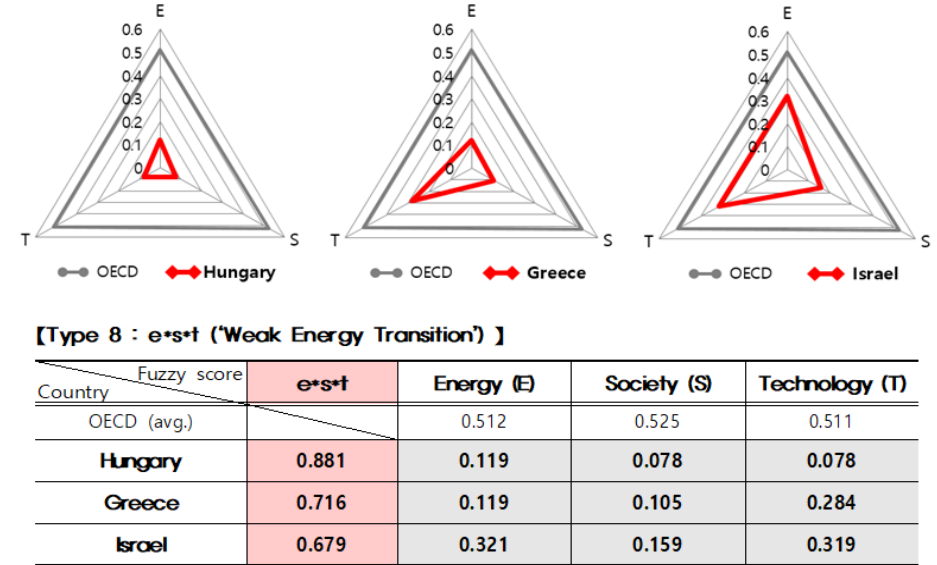
Figure 3. Comparison of the main results by OECD countries: Type 8.